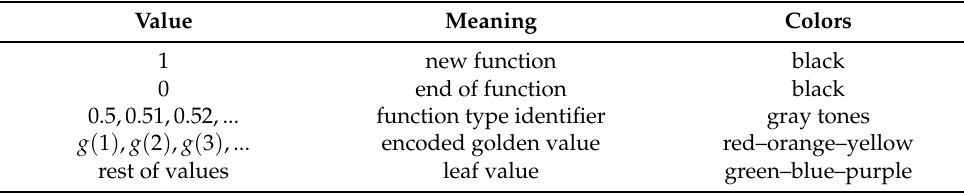
Table 2. Color code for vector visualization.